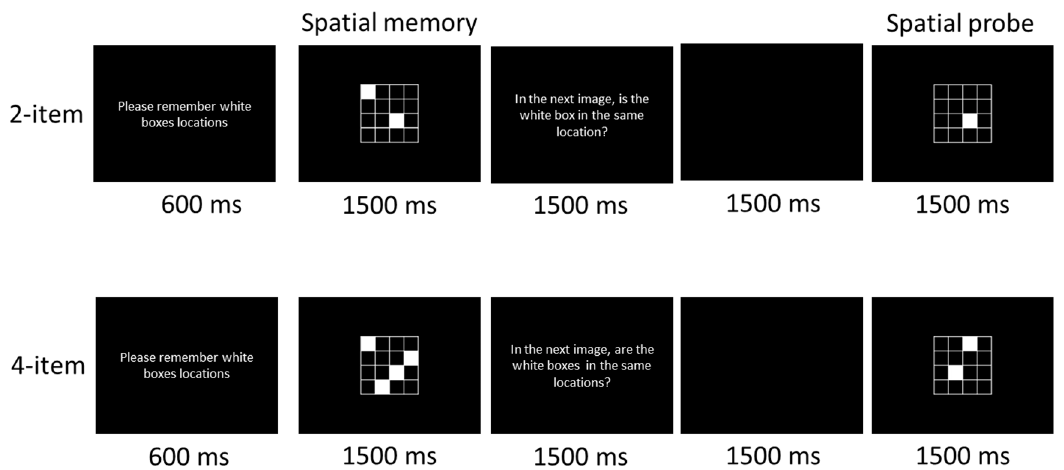
Figure 1. Schematic of the visuospatial working memory task.